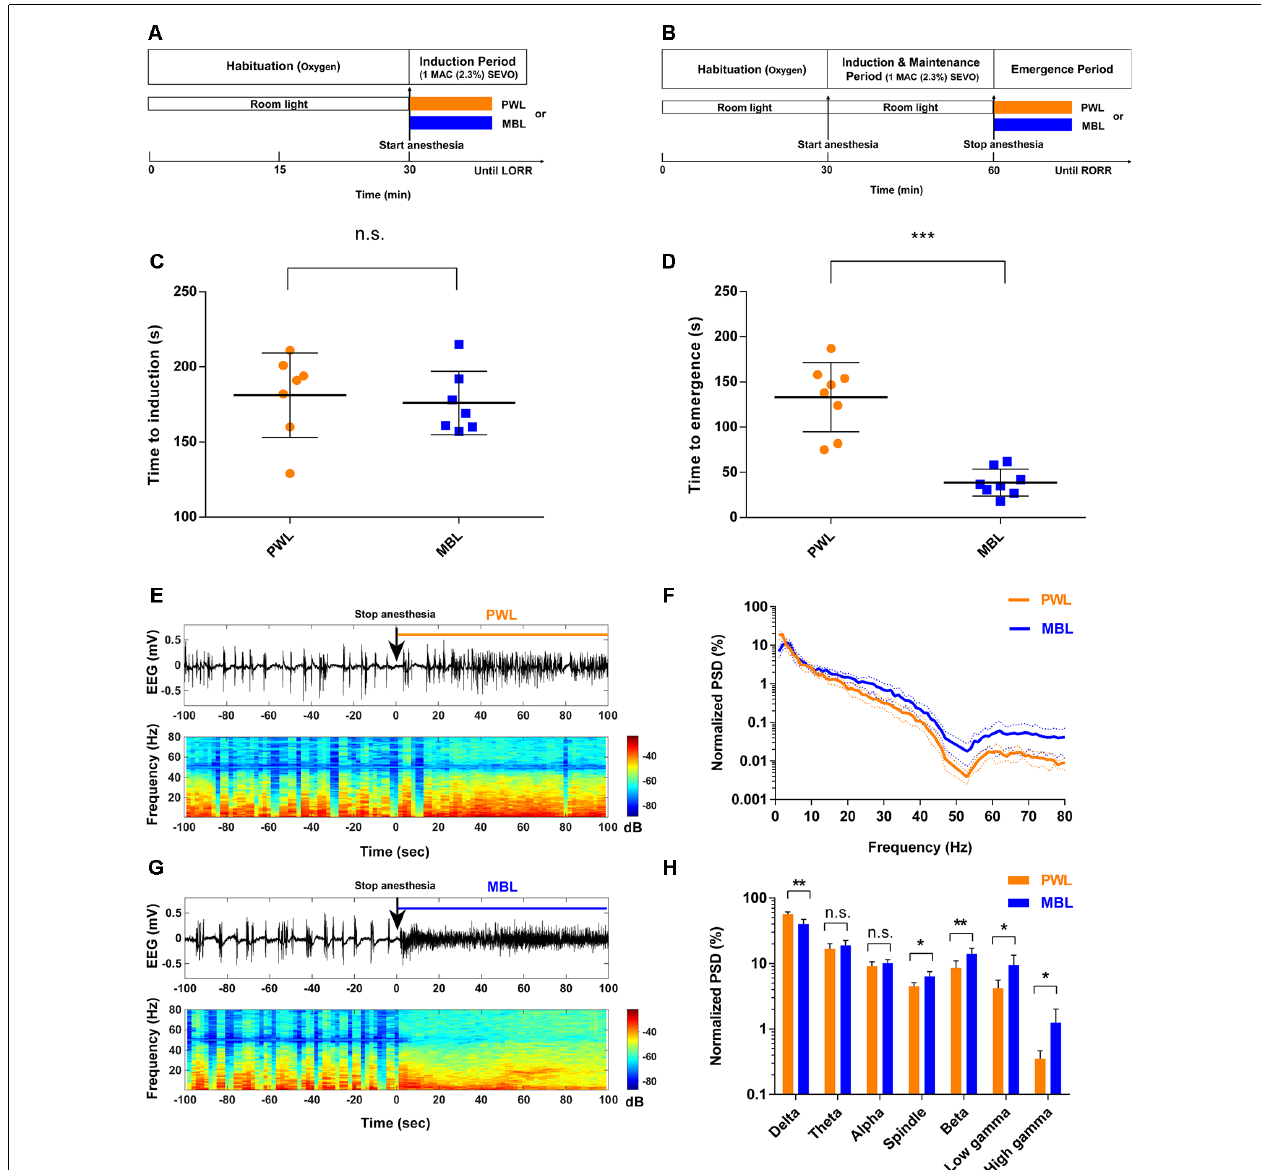
FIGURE 1 | Monochromatic blue light (MBL) accelerated emergence from sevoflurane general anesthesia. (A,B) Timeline for light conditions administered during the induction (A) and recovery (B) periods with sevoflurane general anesthesia. (C,D) Induction (C) and emergence (D) times of anesthesia-induced by 1 minimum alveolar concentration (MAC; 2.3%) sevoflurane in the polychromatic white light (PWL) and MBL groups. MBL decreased the time to emergence (PWL, 133.10 ± 38.26 s, vs. MBL, 38.75 ± 14.96 s; *** p < 0.001 compared with PWL, n = 8 in each group, unpaired Student’s t -tests with Welch’s correction), while did not affect on the induction time (PWL, 181.10 ± 28.03 s vs. MBL, 176.00 ± 21.10 s) compared to PWL (n.s. = not significant compared with PWL, n = 7 in each group, unpaired Student’s t -tests with Welch’s correction). Data are expressed as mean ± SD. (E,F) Representative electroencephalogram traces (upper) and electroencephalogram power spectrogram (lower) in a mouse administered PWL (E) or MBL (F) . Time 0 indicates stopping sevoflurane anesthesia and the beginning of light stimulation. The orange and blue lines indicate the 100 s intervals used for power spectral density comparisons. (G) Normalized group power spectral densities (PSD) in the PWL (orange) and MBL (blue) groups. (H) MBL decreased the relative electroencephalogram delta power and increased the spindle, beta, low gamma, and high gamma power compared to PWL (* p < 0.05, ** p < 0.01 compared with PWL, n.s. = not significant, n = 6 in each group, unpaired Student’s t -tests with Welch’s correction). Data are expressed as mean ± SD. PWL, polychromatic white light; MBL, monochromatic blue